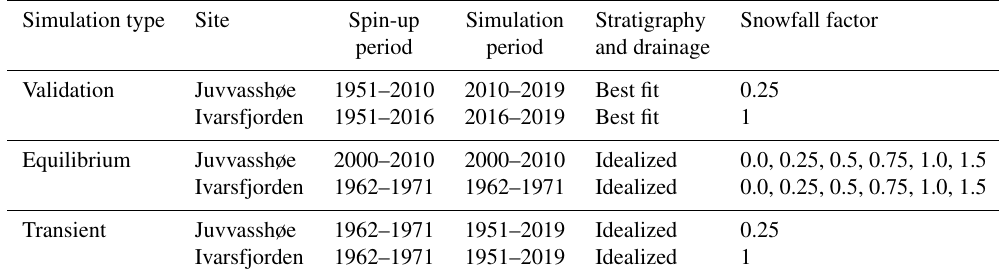
Table 2. Overview of basic model settings for the different simulation types. A spin-up of subsurface temperatures is achieved by repeated simulations for the spin-up period (until a stable temperature profile is reached), before the actual model run for the simulation period is conducted. “Idealized” stratigraphy and drainage refers to three subsurface stratigraphies (Table 1) combined with two types of drainage conditions. See Sects. 3.3.1–3.3.3 for